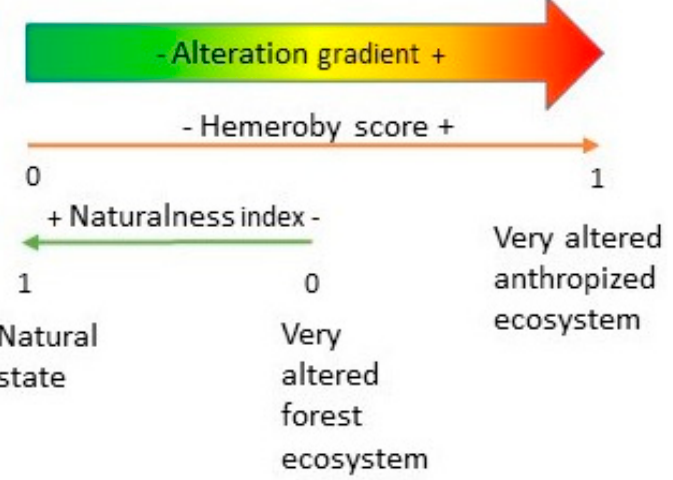
Figure 1. Naturalness and hemeroby along the alteration gradient (adapted from Winter et al . [17] ).